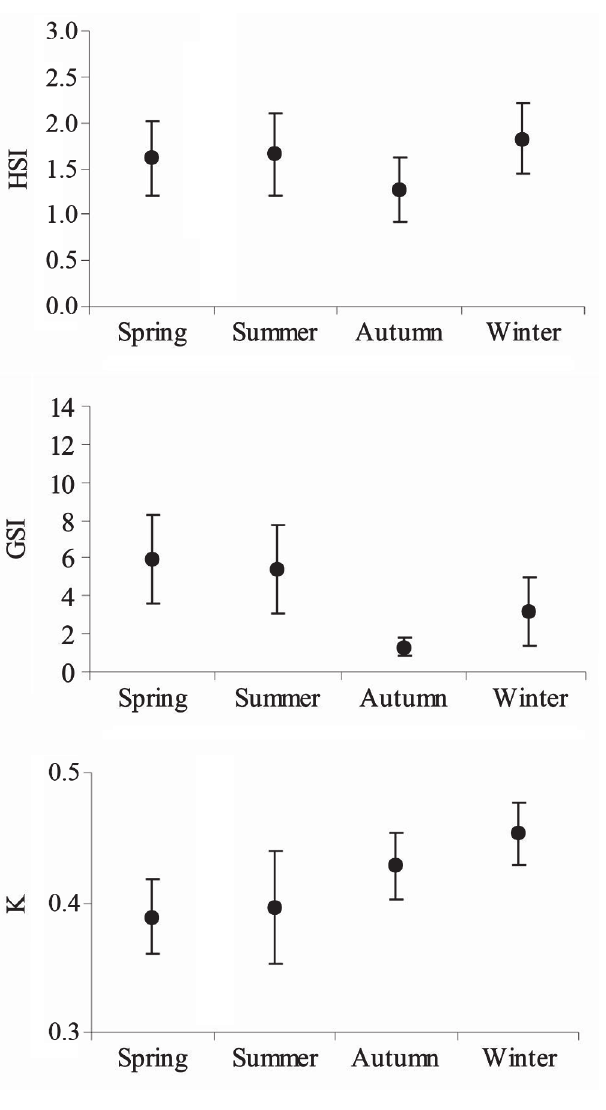
Fig. 2. Seasonal variation of lipid content in muscle, gonad and liver of Percophis brasiliensis